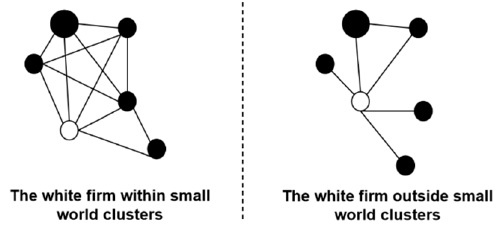
Figure 2. The embeddedness within small-world clusters.